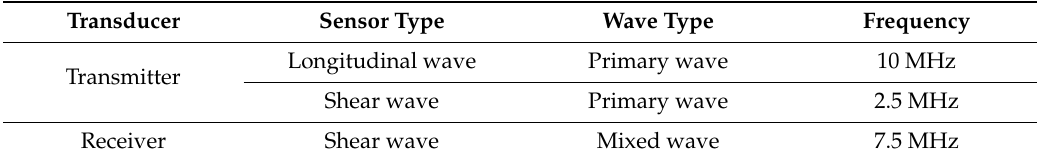
Table 3. Experimental conditions for wave mixing technique.